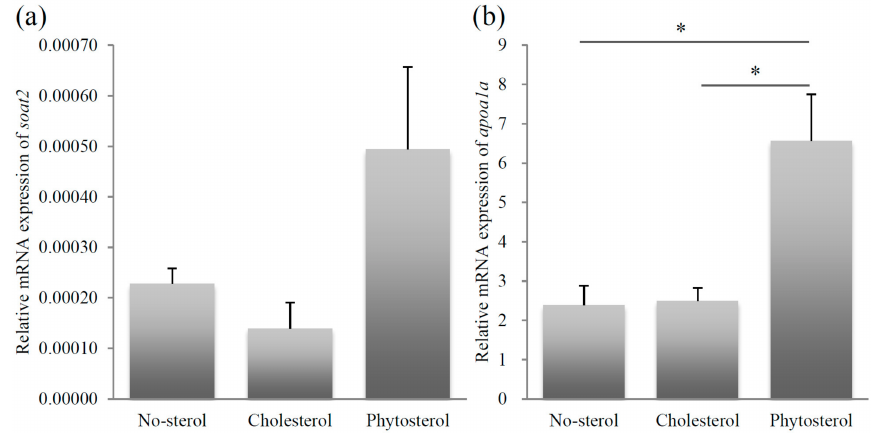
Figure 3. Relative mRNA expression levels of soat2 ( a ) and apoa1a ( b ). Left column: no-sterol group, Middle column: cholesterol-fed group, Right column: sitosterol-fed group. Data were expressed as mean ± SE ( n = 10, per group). Statistically significant difference is shown as * p <